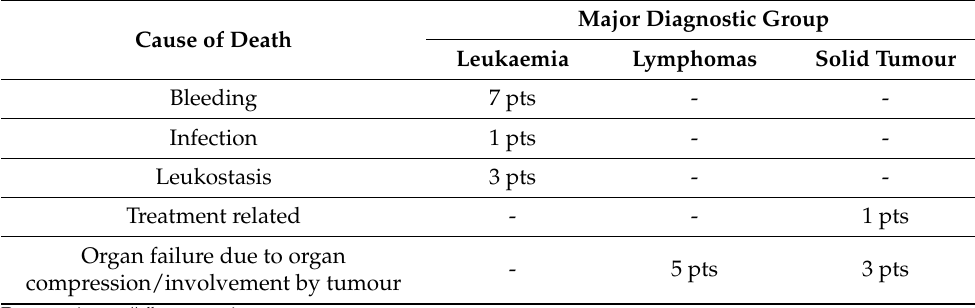
Table 3. Causes of death by pathophysiology among major cancer diagnostic groups. Cause of Death